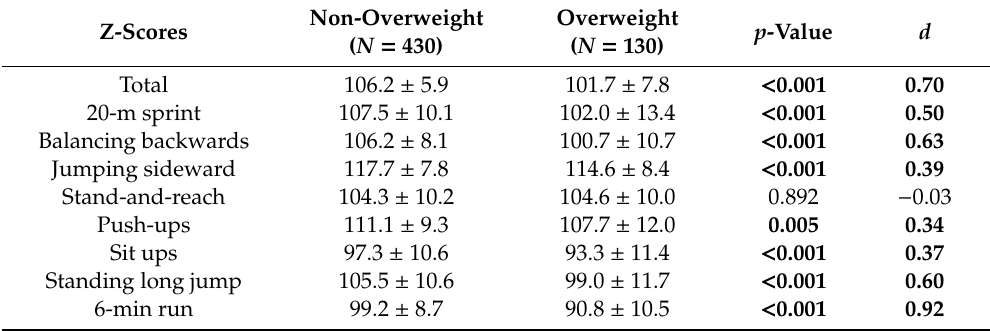
d : e ff ect size Cohen’s d . Bold values indicate significant di ff